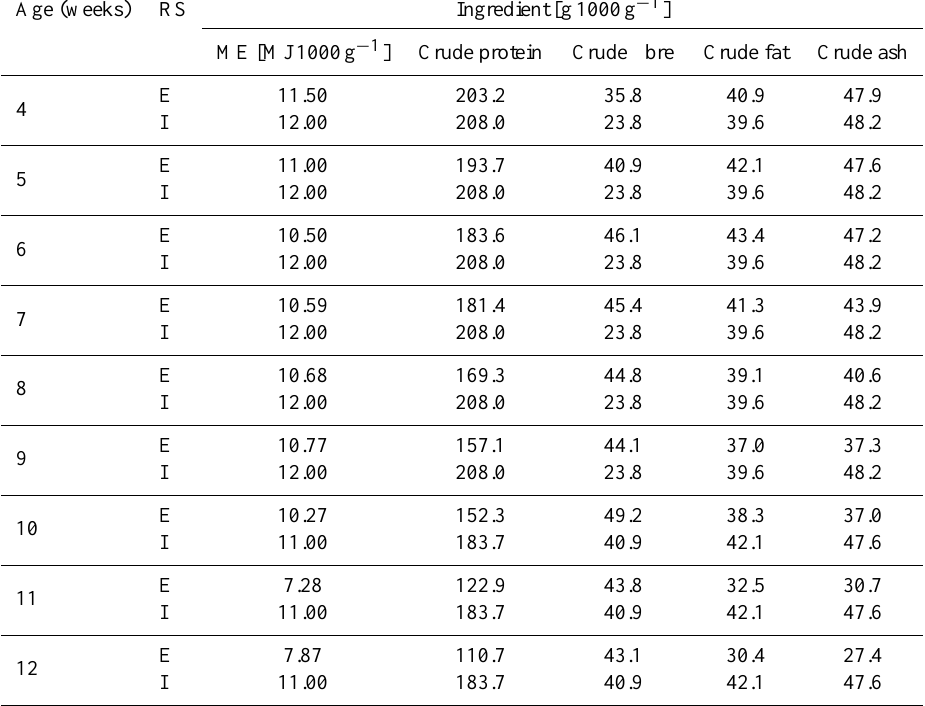
Table 3. Nutritive values of feeds used in the experiment, depending on the system of